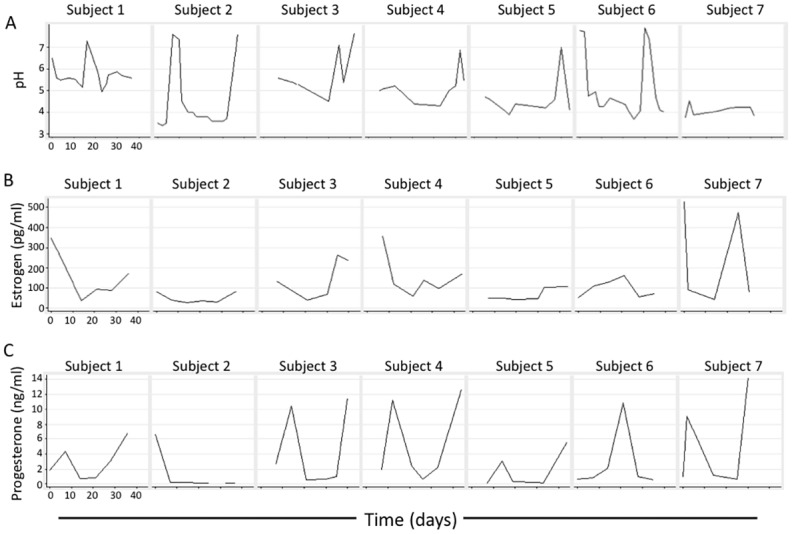
Longitudinal vaginal pH, serum estrogen and progesterone.Vaginal pH (A) was determined utilizing a sterile pH probe as described in Methods. Blood was drawn from the seven subjects shown in Fig 1. Serum levels of estrogen (B) and progesterone (C) were measured by ELISA.